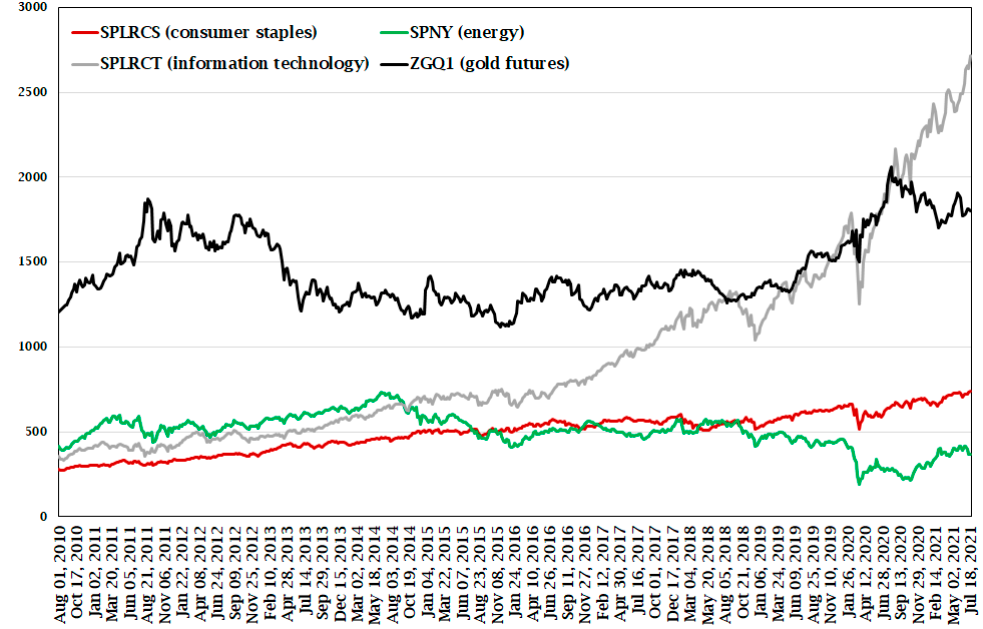
Figure 1. Consumer staples, energy, information technology and gold futures.